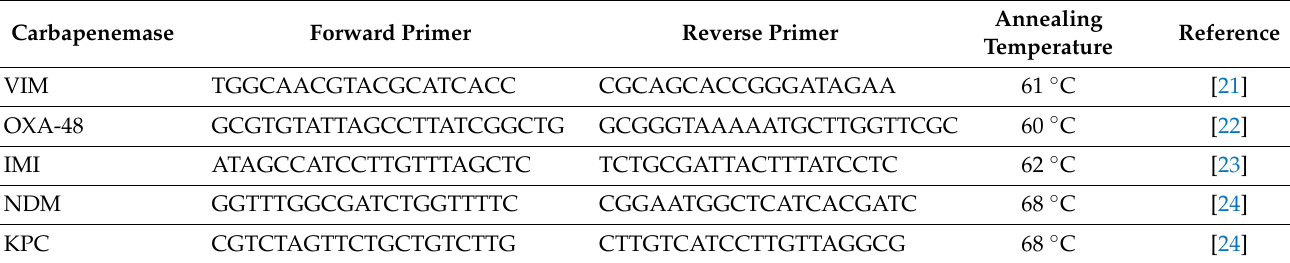
Table 1. PCR primer sequences for the analysed carbapenemases.